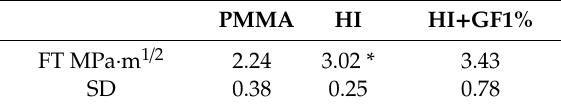
Figure 18. Fracture toughness of the plain acrylic denture base resin, high-impact denture base resin and its composite with acrylic coated class flakes. Table 6. Fracture toughness of the plain acrylic denture base resin, high-impact denture base resin and its composite with acrylic coated class flakes. * Statistically significant compared to the plain